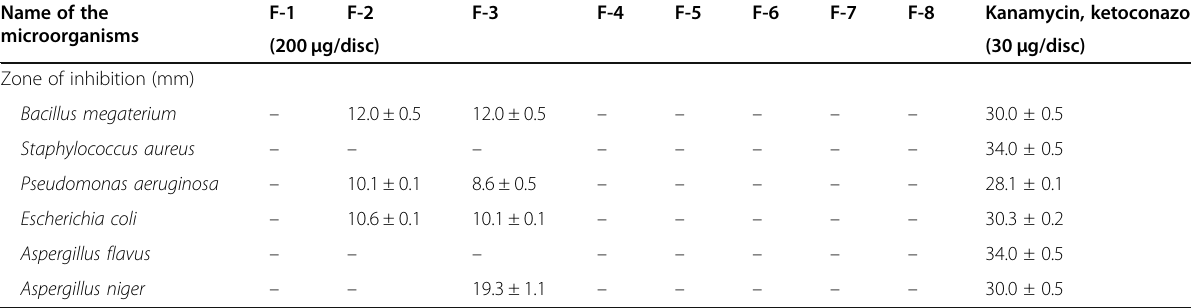
Table 2 Zone of inhibition of different fractions of T. maxima , kanamycin and ketoconazole Name of the microorganisms